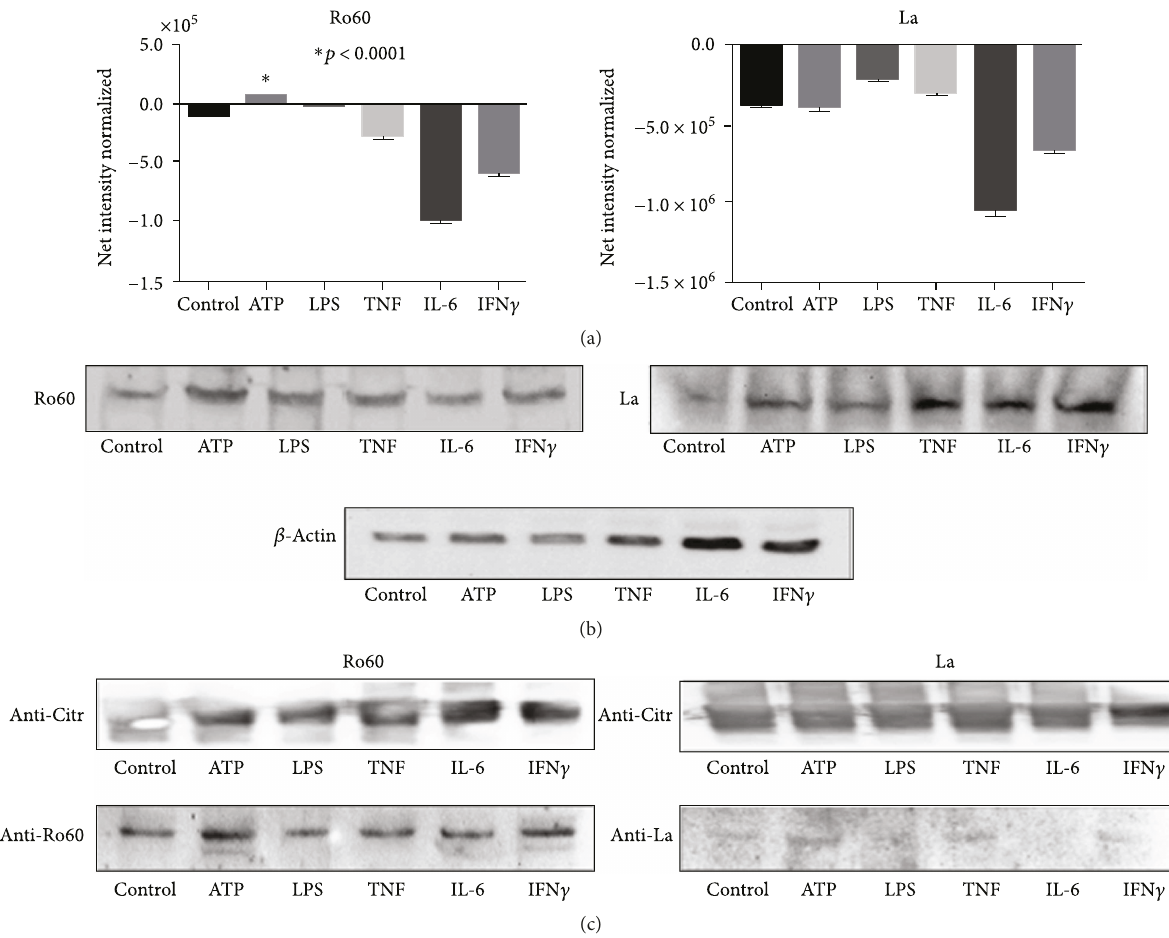
Figure 7: Expression and citrullination of Ro60 and La ribonucleoproteins under stimulation, by Western blot analysis. (a) Graphs show net intensity normalized for the corresponding Ro60, and La bands show a moderate increase of Ro60 induced by ATP ( p < 0 0001 by t -test). La ribonucleoprotein also shows discrete changes regarding its own control without stimulants. (b) Western blots of Ro60, La ribonucleoproteins, and β -actin (control protein). (c) Superior panel shows immunoprecipitation assays of citrullinated proteins blotted and probed with anti-Ro or anti-citrulline. Positive bands at 60 kDa (left) and 48kDa (right) were marked, and membranes were then stripped and reprobed with an anti-Ro60 (left inferior panel) and anti-La (right inferior panel). It is evident that Ro60 had a wide citrullination process specially by ATP and IFN γ stimulation. Immunoprecipitates of La ribonucleoprotein display faint citrullination signal under ATP